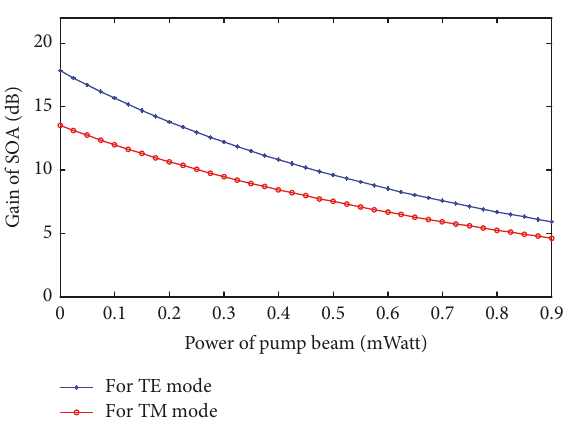
Figure 4: Variations of gain of SOA for different